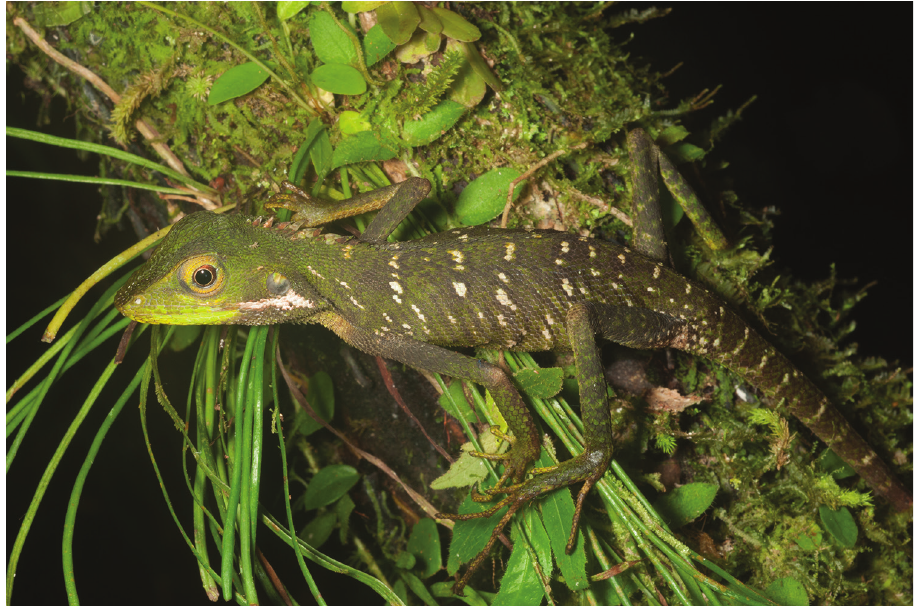
Figure 39. Bronchocela sp. male (KU 334441) from Eye Falls, Mt. Hilong-hilong, Municipality of Re- medios T. Romualdez, Agusan del Norte Province. Photo: